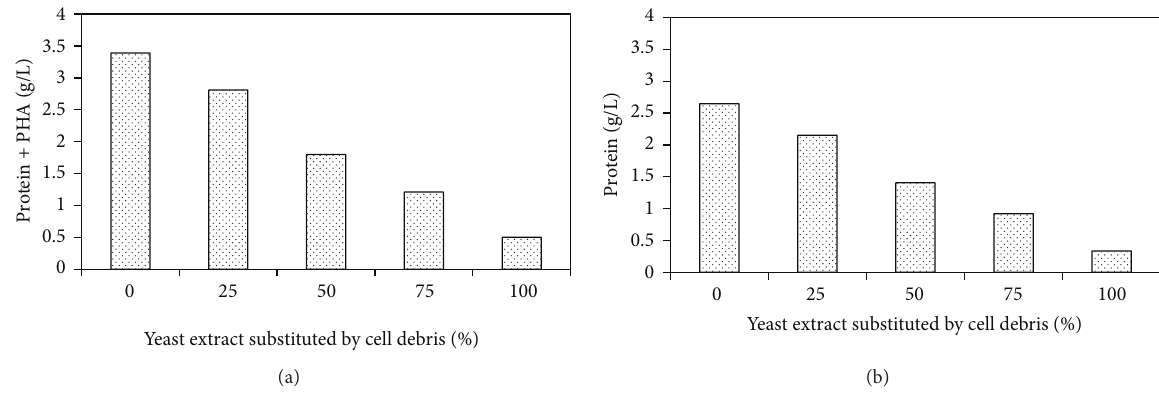
Figure 6: Produced concentrations of protein plus PHA (a) and protein (b): the classic nitrogen and phosphate source yeast extract not (0%), partly (25, 50, and 75%), and totally (100%) substituted by salt-free cell debris (SD). Cultivation of H. mediterranei DSM